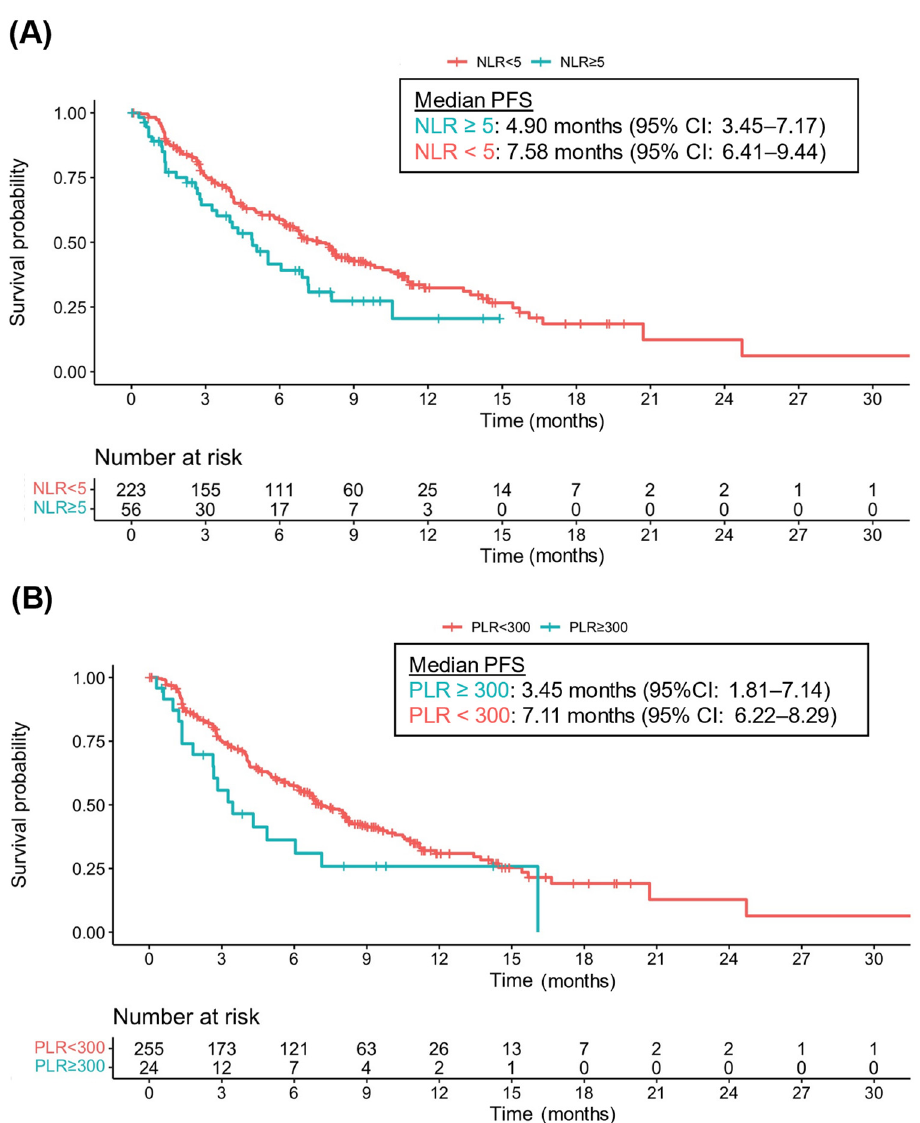
Figure 2. Kaplan–Meier curves for progression-free survival (PFS) according to neutrophil-to-lymphocyte ratio (NLR) and platelet-to-lymphocyte ratio (PLR) status: ( A ) PFS according to NLR; ( B ) PFS according to PLR.